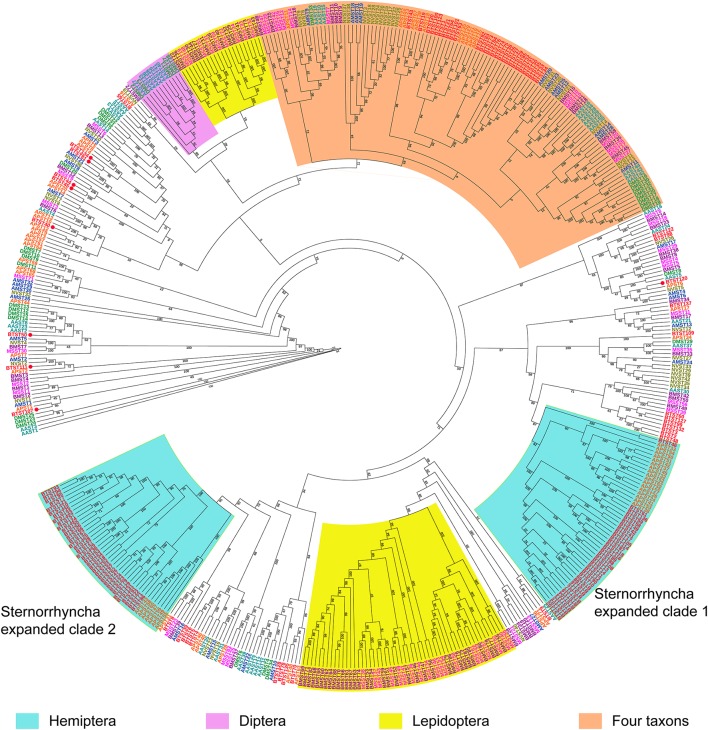
A maximum-likelihood tree of STs in B. tabaci and seven other insects. The analysis was constructed with Raxml V8.2.4 and the LG+F+I+G model. Bootstrap values expressed as percentages of 1000 replications are shown at branch points. Sternorrhyncha (AP, A. pisum, orange; BT, B. tabaci, red), Hymenoptera (AM, A. mellifera, blue; NV, N. vitripennis, brown), Diptera (AA, A. aegypti, cyan; DM, D. melanogaster, green), Lepidoptera (BM, B. mori, dark purple; MS, M. sexta, bright purple).